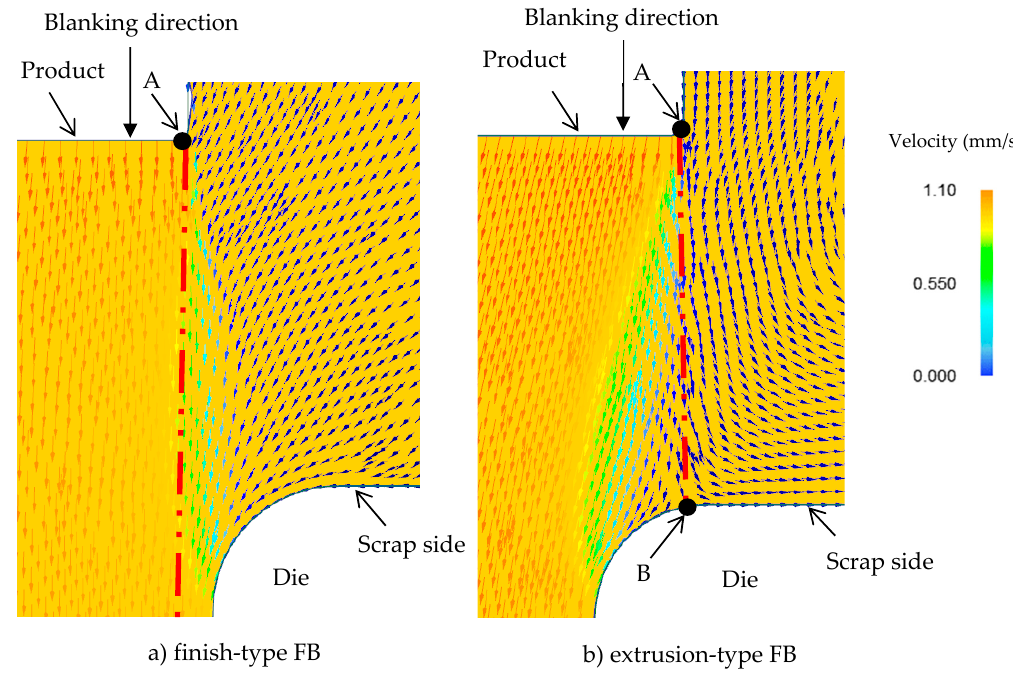
Figure 7. Comparison of material flow for 80% t punch penetration between finish-type FB and extrusion-type FB, in an enlarged view: ( a ) finish-type FB; ( b ) extrusion-type FB.